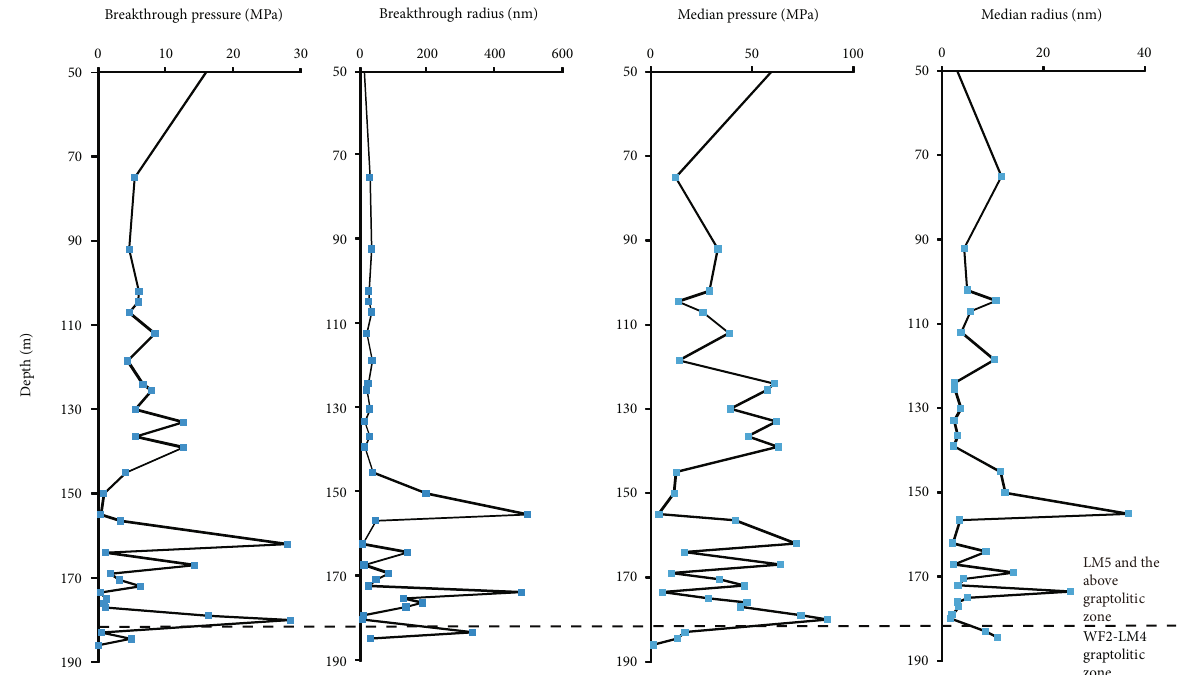
Figure 9: The breakthrough pressures, breakthrough radius, median pressures, and median radius (mercury injection capillary pressure data) of the Wufeng and Longmaxi Formations, Guanyinqiao section, Qijiang County, Chongqing Municipality. Because the shale of the outcrop sample is weathered to di ff erent degrees, the breakthrough radius and the median radius are large, while the breakthrough pressure and the breakthrough radius are small. However, the overall performance is that the breakthrough pressure and median pressure of the WF2-LM4 GZ is lower than those of the LM5-LM8 GZ, showing the stronger sealing capacity of the LM5-LM8 GZ which is a direct seal for the WF2-LM4